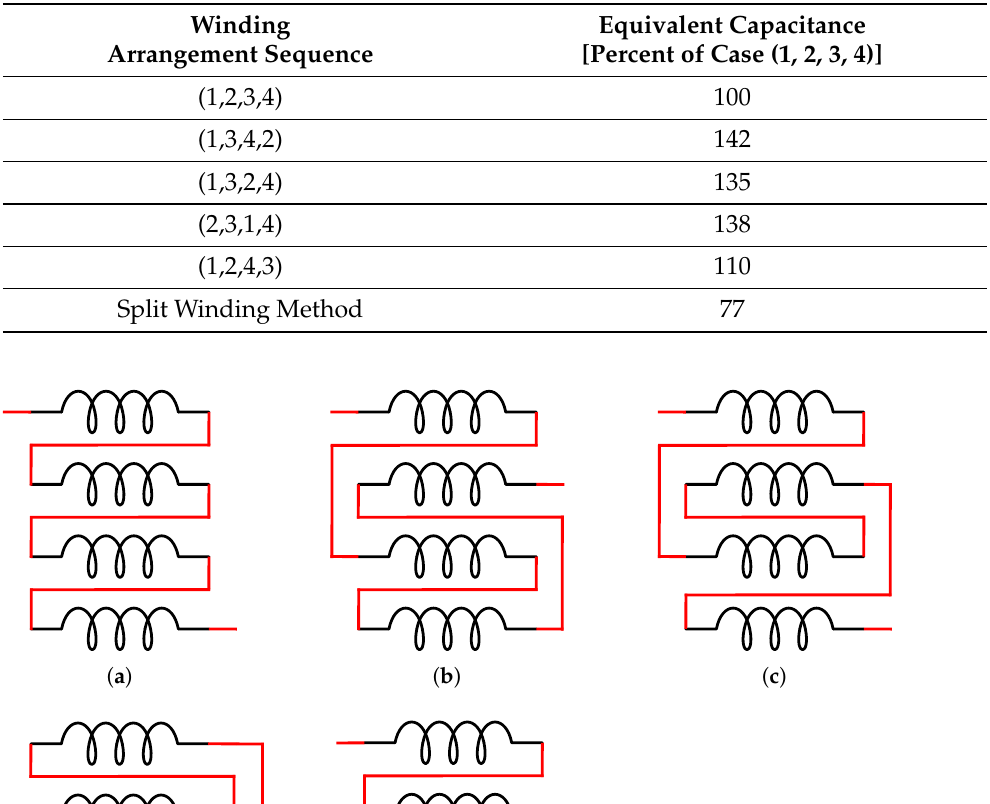
Table 3. Comparison of equivalent capacitances for different winding arrangements within the layers. Figure 19 illustrates the various configurations mentioned here.